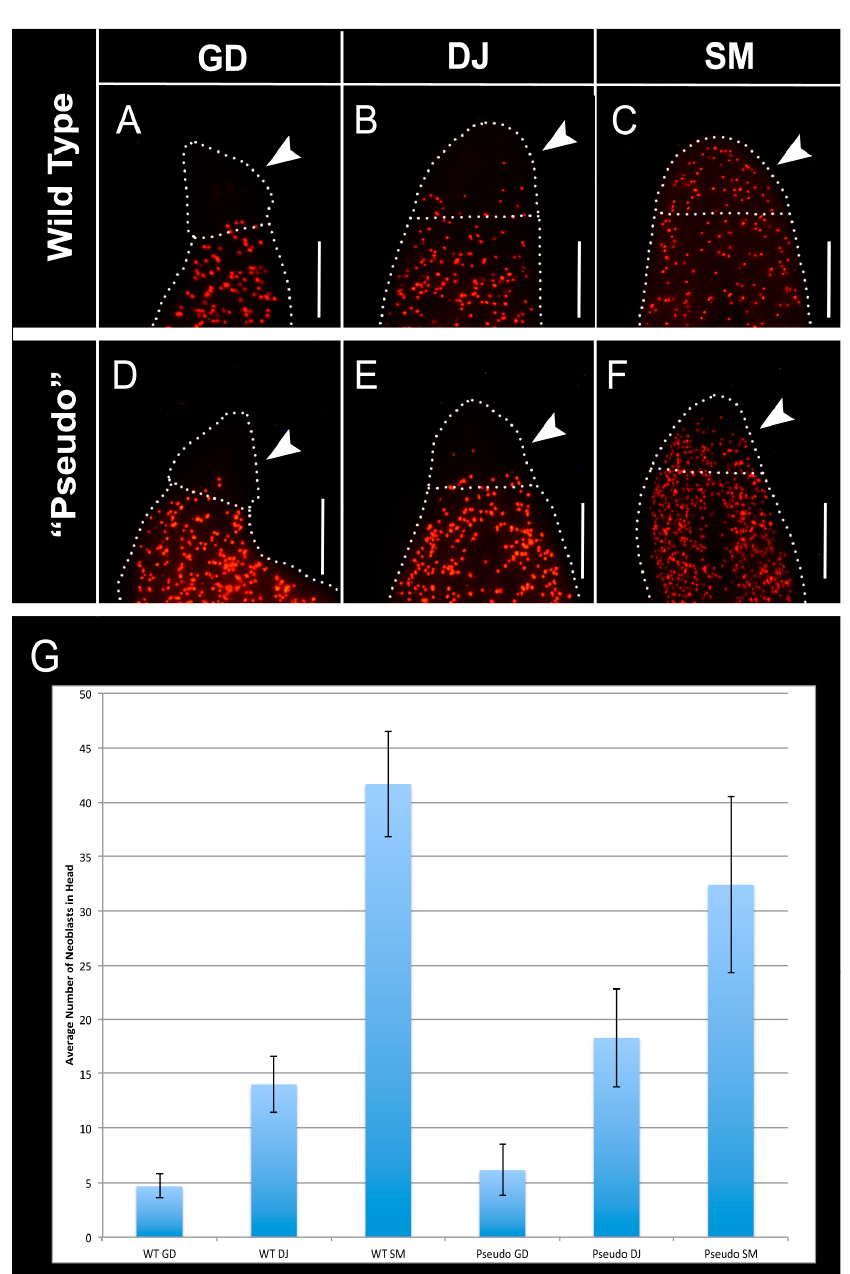
Figure 5. Neoblast (red dots) distribution is altered after octanol treatment. ( A – C ) Analysis of neoblast distribution by staining of phosphorylated histone H3 in adult, wild-type G. dorotocephala ( n = 9), D. japonica ( n = 9), and S. mediterranea ( n = 9) planarians. Dotted lines indicate edges of worm anatomy, as well as 1/6th of the length of the worm body from the anterior tip of the worm. This distance was used to define the posterior boundary of the head. Arrows indicate the region in which neoblasts were counted; ( D – F ) Analysis of neoblast distribution in G. dorotocephala regenerates treated in 8-OH that resembled G. dorotocephala heads ( n = 7), D. japonica heads ( n = 8), and S. mediterranea heads ( n = 7), by anti-phosphorylated histone H3 staining. Arrows indicate region in which neoblasts were counted. Scale bar 0.5 mm; ( G ) Average number of neoblasts in the anterior 1/6th of wild-type, and 8-OH treated worms (ANOVA p < 0.05). Error bars are standard deviations.